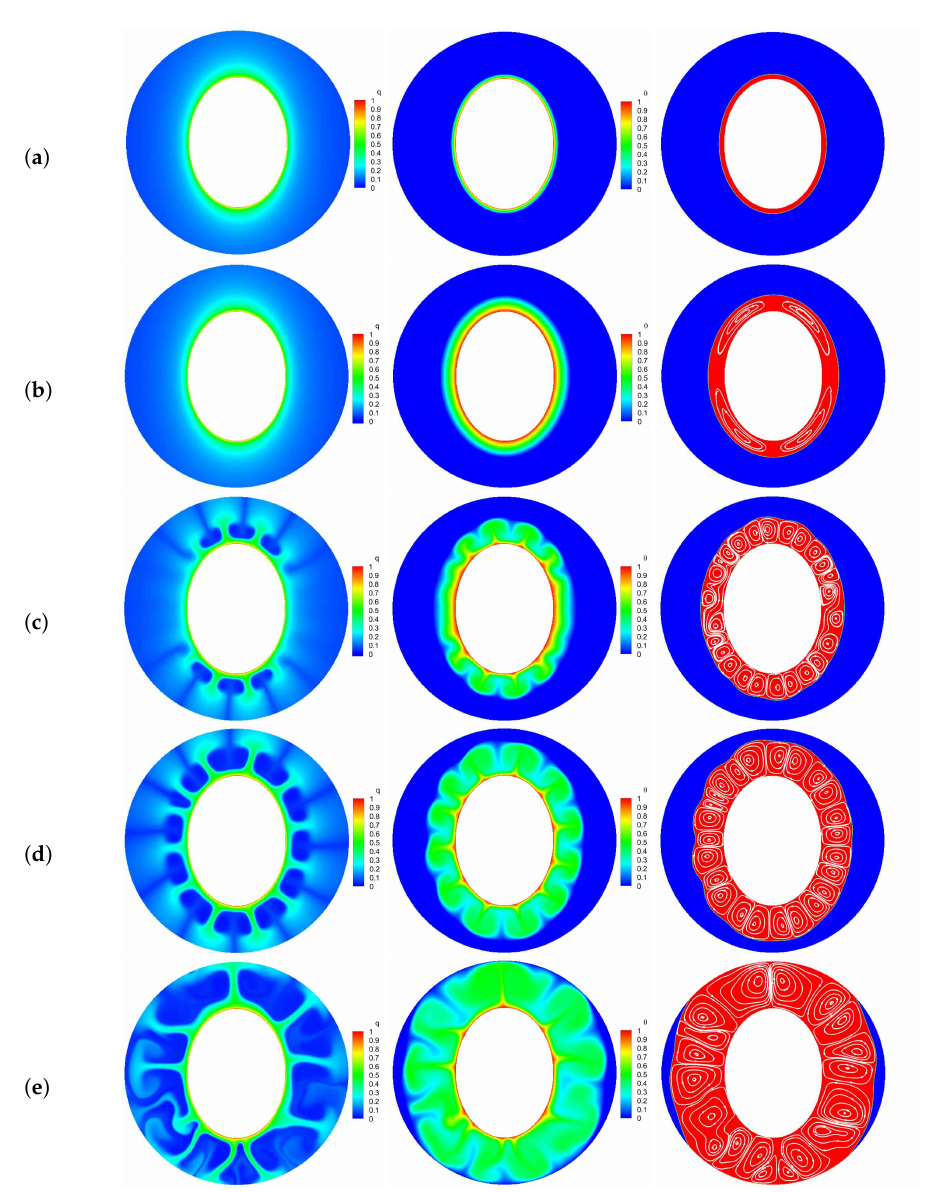
Figure 6. The transient distributions of charge density, temperature field and the liquid fraction with streamlines at five representative instants [( a ) point A , Fo = 0.045; ( b ) pont B , Fo = 0.498; ( c ) point C , Fo = 1.019; ( d ) point D , Fo = 1.381; ( e ) point E , Fo = 2.491]. Parameters: Ra = 0, T = 500, AR =